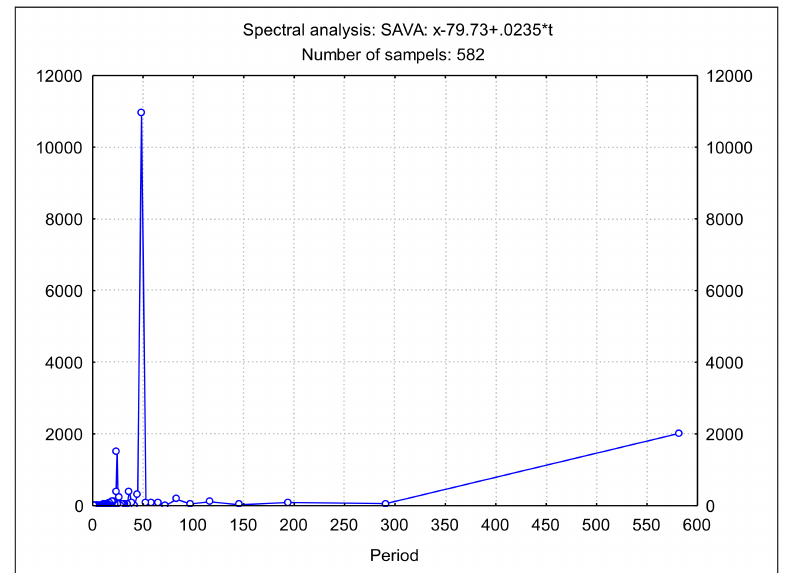
Figure 6. Fourier analysis of water level oscillation of the Sava.